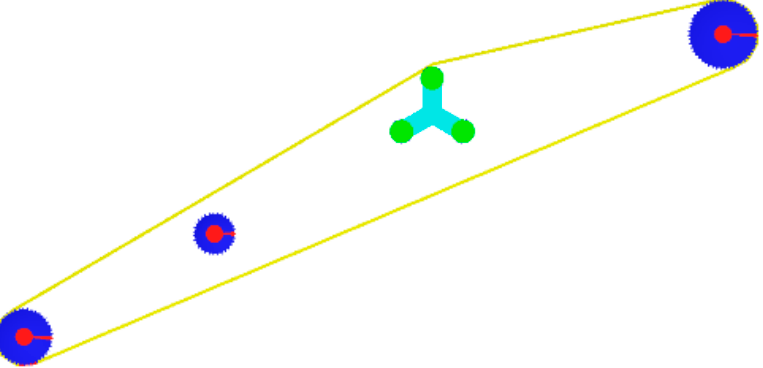
Figure 9. Virtual model of the film and soil separation mechanism.